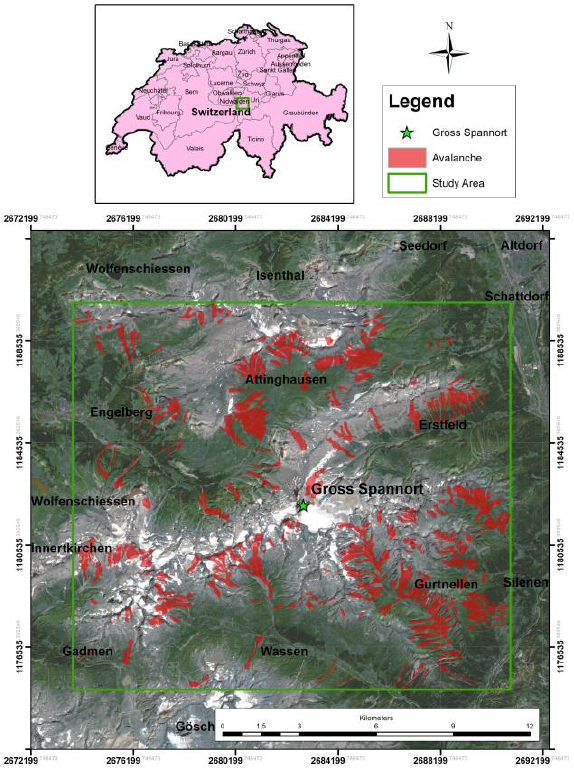
Figure 1. Location of the study area.